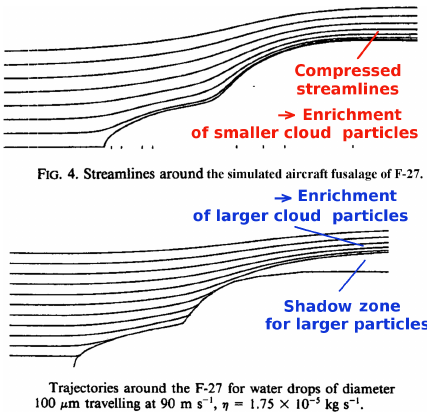
Figure 1. Three-dimensional potential flow simulations of gas streamlines and particle trajectories around an aircraft shaped body, adapted from King (1984) (with annotations).